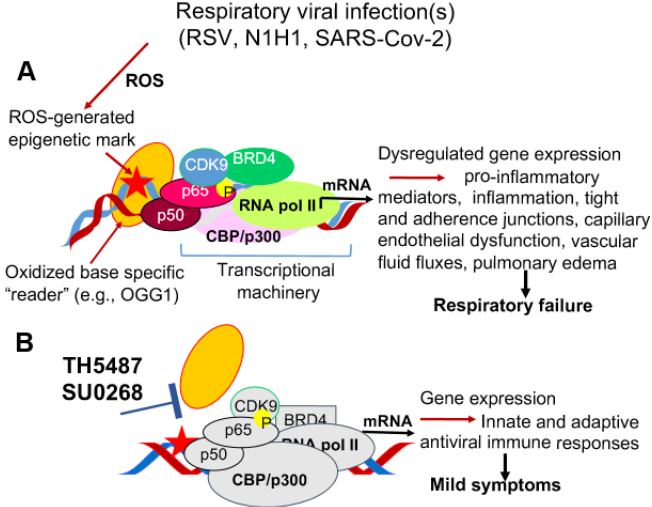
Figure 3. Proposed depiction of endothelial dysfunction by ROS in respiratory virus-infected airways and potential therapeutic intervention. ( A ) Oxidative modification to the heterocyclic DNA base guanine(s) in gene regulatory sequences is considered an epigenetic mark that is recognized by the “reader” OGG1, leading assembly of transcriptional complex and dysregulated gene expression. Consequences are pulmonary edema, congestion, respiratory failure in patients with risk factor(s). ( B ) Inhibition of OGG1 ′ interaction with epigenetic mark decreases extent of inflammation and manifestation of endothelial dysfunction. TH5487, and SUO268, OGG1 specific inhibitors; BRD4, bromodomain-containing protein 4; CDK9, cyclin-dependent kinase 9; p50-p65, nuclear factor kappa B; CBP/p300, RNA pol II, RNA polymerase II.